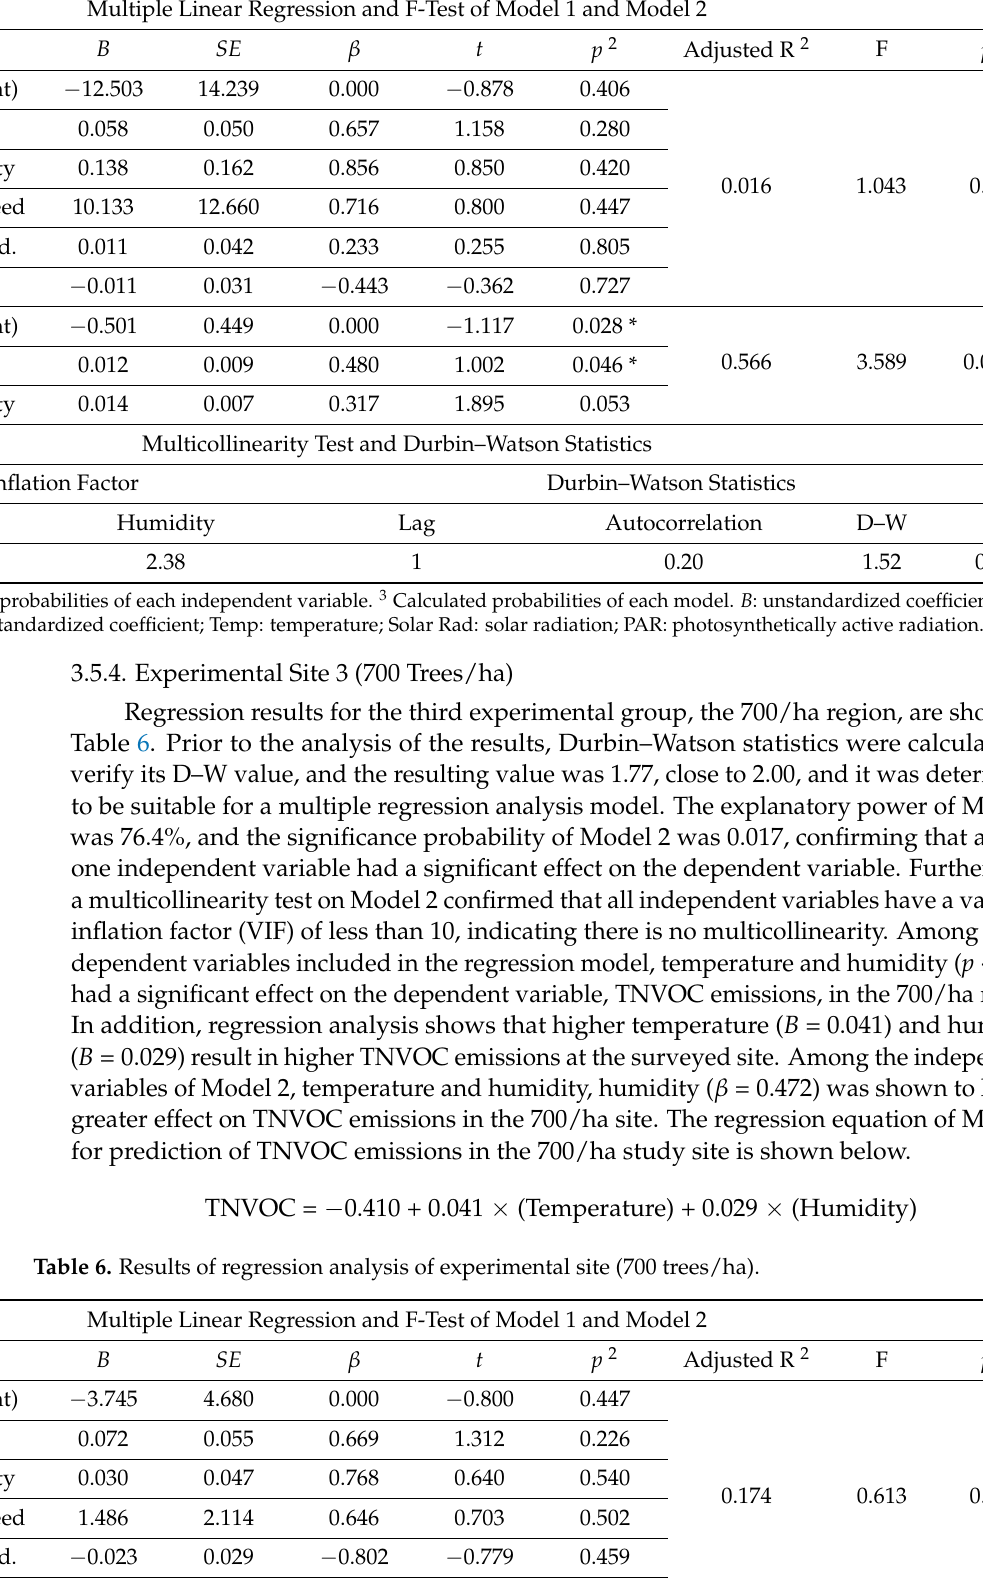
Table 5. Results of regression analysis of experimental site (600 trees/ha). Multiple Linear Regression and F-Test of Model 1 and Model 2